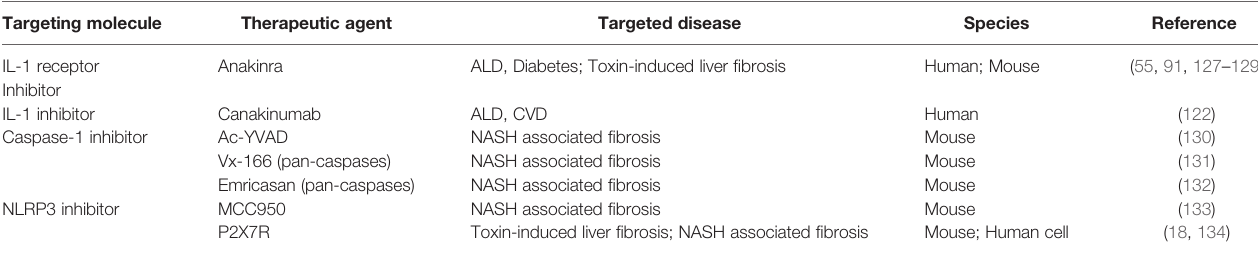
TABLE 1 | Potential Therapeutic Agents for liver fi